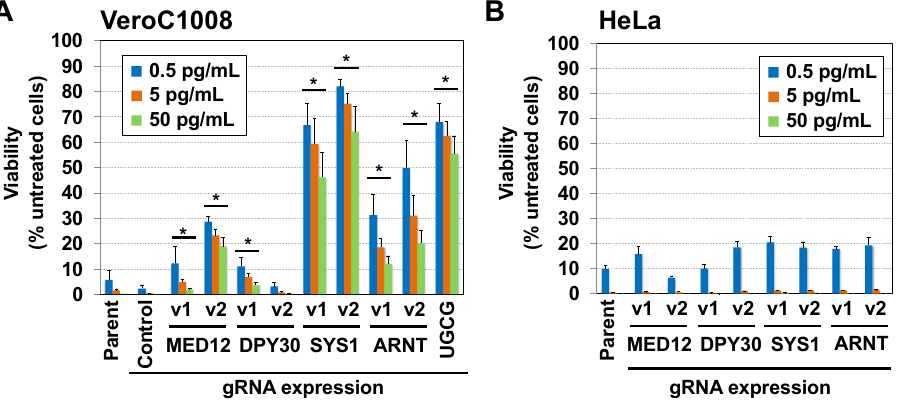
Figure 2. Unique genes enriched in the Vero screen. The reproducibility of STx resistance conferred by individual sgRNAs. Each sgRNA was lentivirally transduced into CAS9-expressed ( A ) Vero C1008 and ( B ) HeLa cells. The cells were treated with STx at the indicated concentrations (boxes) for 3 days. Viability was estimated using an MTT assay and is expressed as a percentage of the MTT value (OD 570 ) in the absence of STx. “Parent” indicates non-transduced Vero C1008#5CAS9#6 cells and HeLa CAS9#W7 cells. “Cont” indicates irrelevant sgRNA (targeted to CD11b )-expressed cells. The percentages shown are the mean percentages ± SD obtained from three independent experiments. The Holm–Bonferroni corrected t -test was used for multiple comparisons. * Asterisks denote statistical significance.